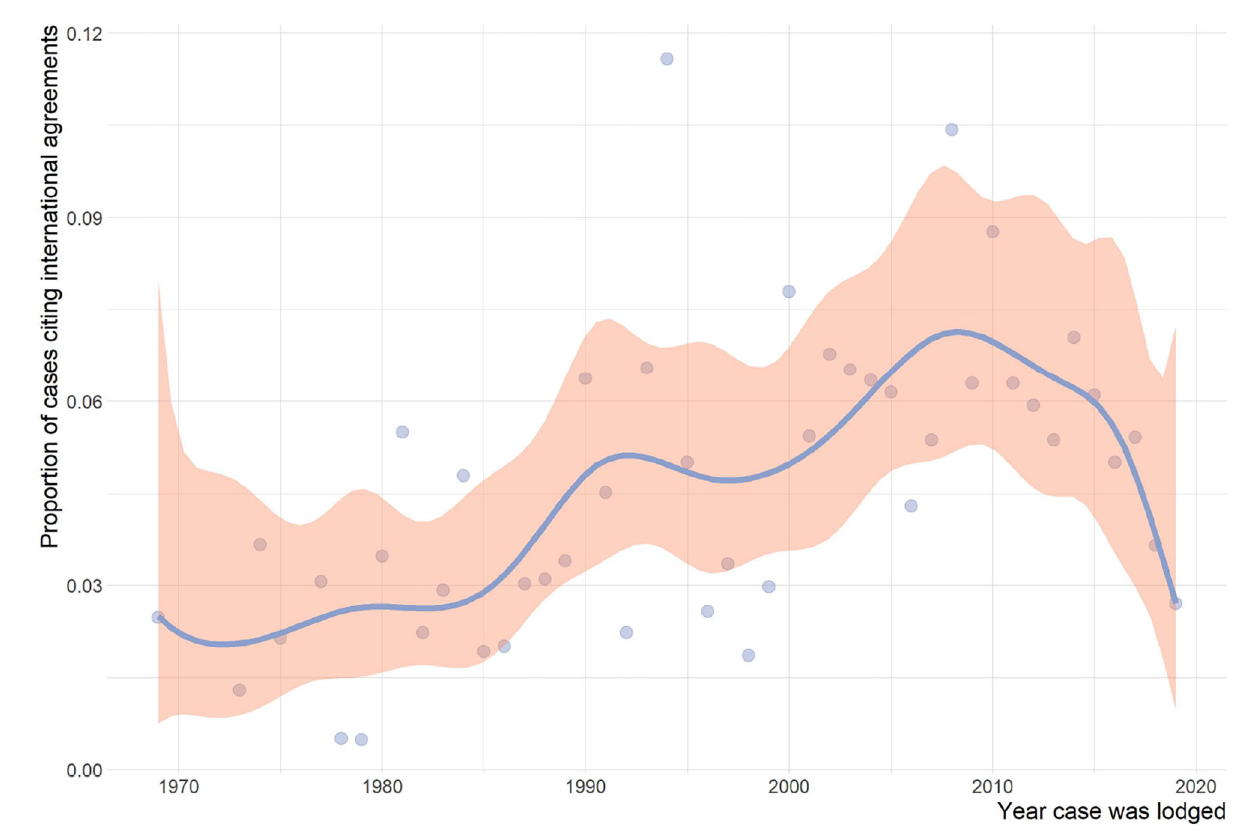
FIGURE 2 | Proportion of EU court cases that contain a reference to at least one international act (1969–2019). We estimate a smoothed trend line with 95 per cent confidence intervals using quasi-binomial